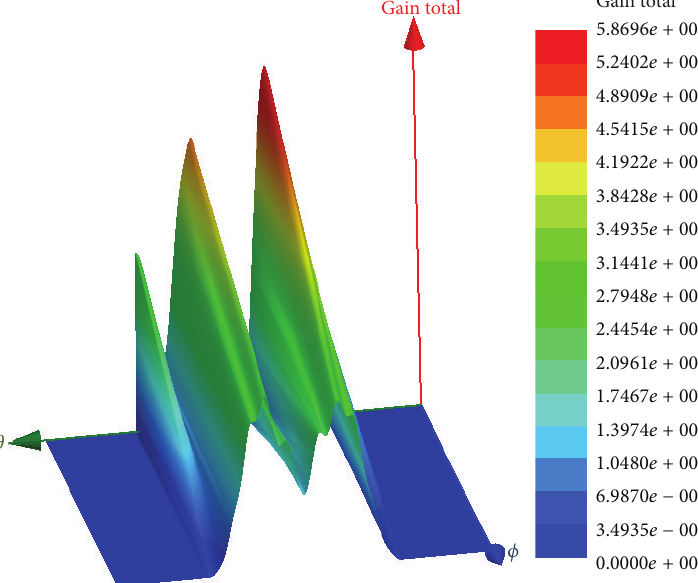
Figure 21: 3D gain of the CRA for the fourth iteration at 8.44 GHz.